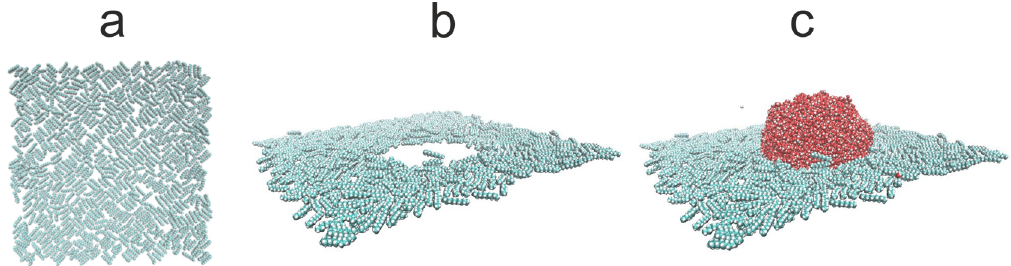
Figure 6. Simulation snapshots (top view) of water droplet on n-decane-covered silicon at C HYDR = 0.73 molecules / nm 2 . The snapshot of the alkane on silicon before the water drop was introduced ( a ), the configurations of alkane molecules after the water drop was introduced (( b ) water molecules are not shown), and the snapshots of water drop with the alkane molecules ( c ). Silicon surface is not shown for clarity.